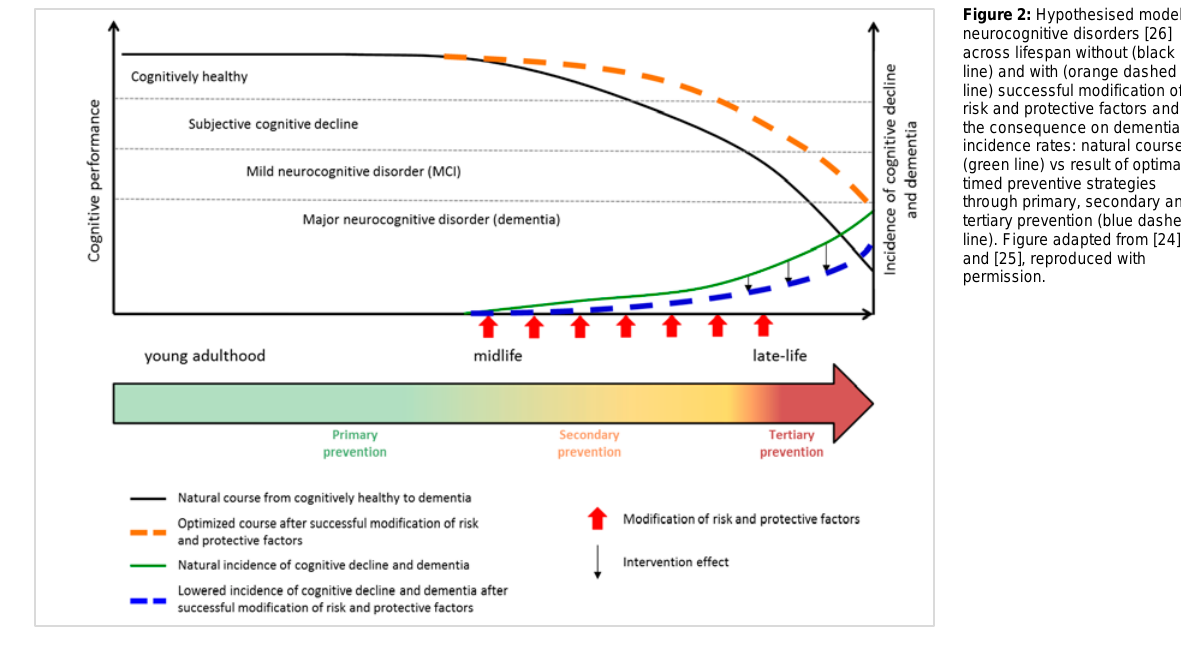
Figure 2: Hypothesised model of neurocognitive disorders [26] across lifespan without (black line) and with (orange dashed line) successful modification of risk and protective factors and the consequence on dementia incidence rates: natural course (green line) vs result of optimally timed preventive strategies through primary, secondary and tertiary prevention (blue dashed line). Figure adapted from [24] and [25], reproduced with permission.